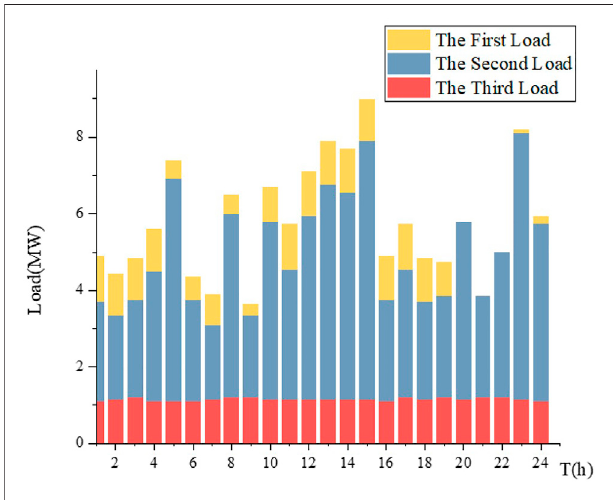
FIGURE 10 | Power distribution of electrical appliances in scene